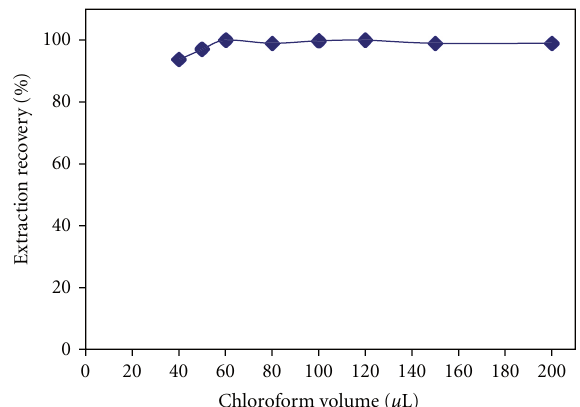
F4:Effectofthevolumeofextractionsolventontheextraction recovery of copper. Extraction conditions: water sample volume,